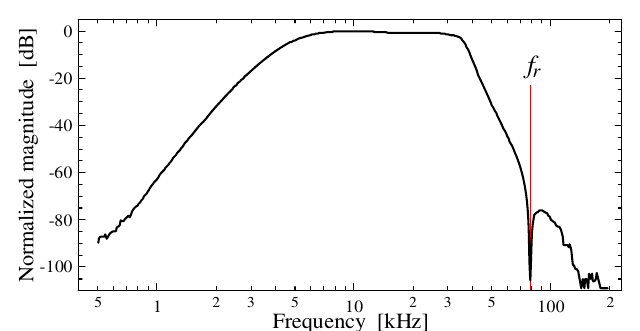
FIG. 8. (Color) RHIC AFE frequency